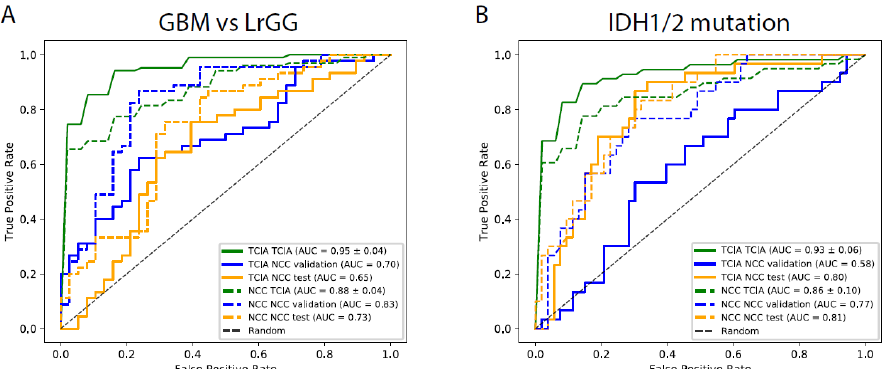
Figure 8. Receiver operating characteristic (ROC) curves for classification results. The ROC curves enable the visualization of results in Figure 7 for GBM ( A ) and IDH prediction ( B ), respectively. Solid and dotted lines show the curves for the highest accuracy model in TCIA and NCC validation set, respectively. Each color corresponds to that used in Figure 7, where green, blue, and yellow depict TCIA, NCC validation, and NCC tests, respectively.